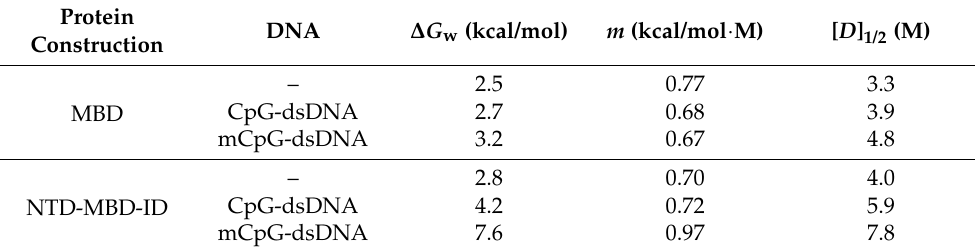
Table 3. Thermal unfolding parameters for MBD and NTD-MBD-ID at pH 7, estimated by by analyzing the denaturant dependence of the spectral average energy.